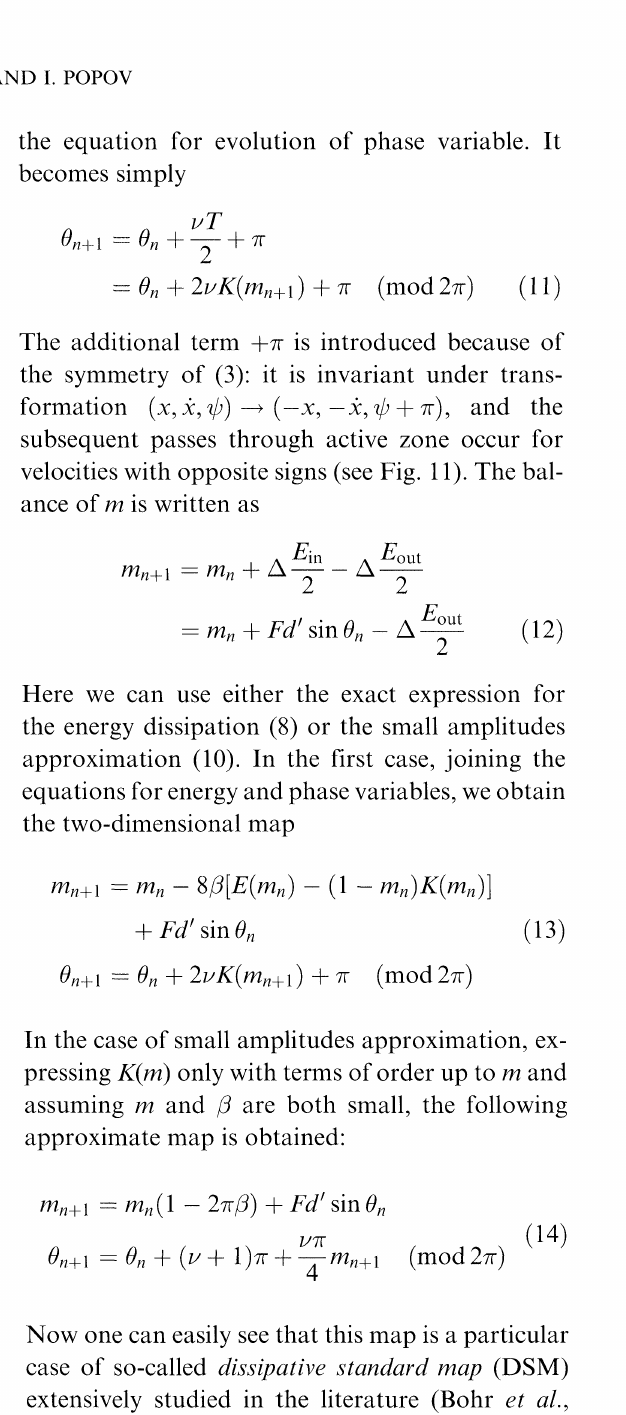
FIGURE 11 The phase points standing for consecutive iter- ations of the map variables along the